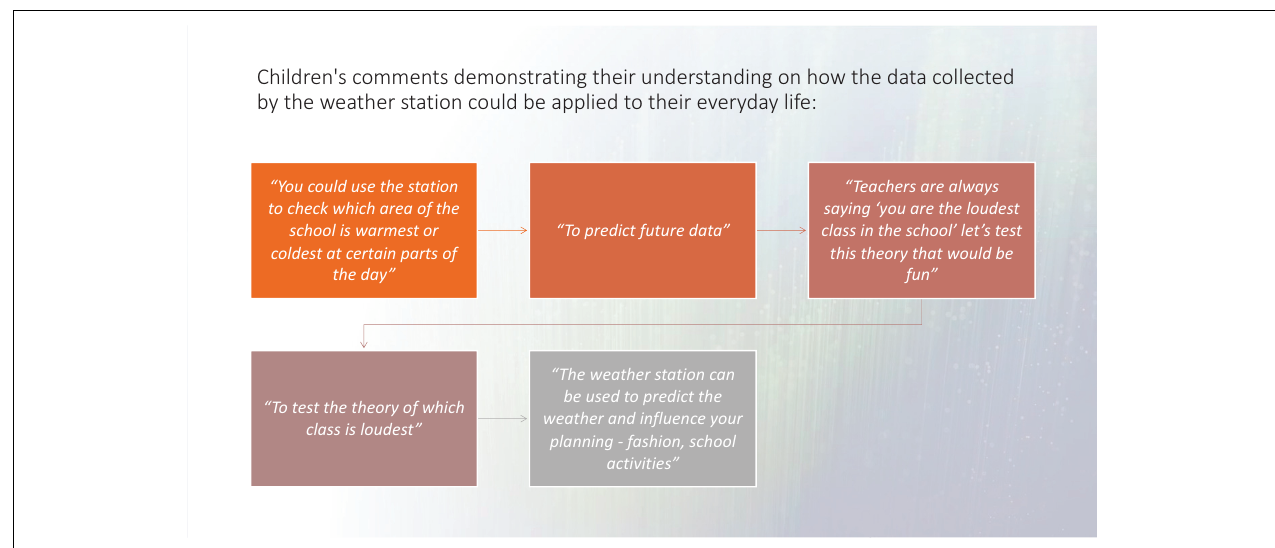
FIGURE 13 | Children’s comments on how data collected from the weather station could be applied to everyday